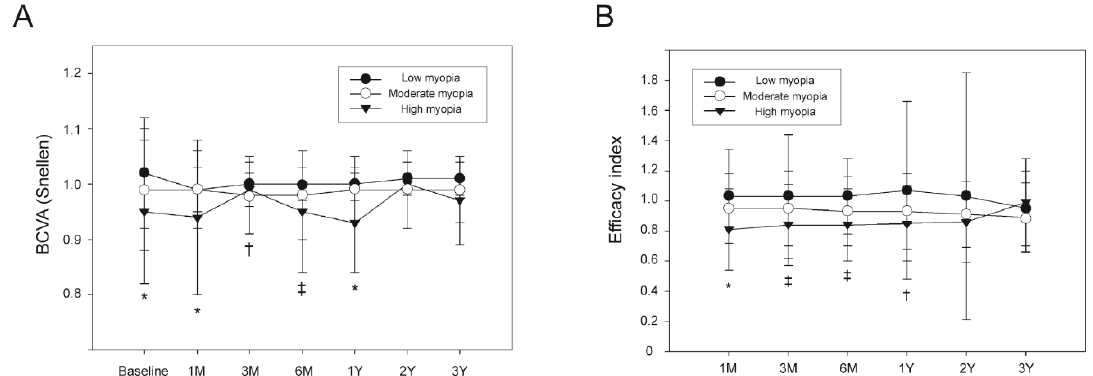
Figure 5. Comparison of best corrected visual acuity and efficacy index according to the degree of myopia. ( A ) BCVA. ( B ) efficacy index. *: significant difference among the three myopia groups ( p < 0.050). †: signi fi cant di ff erence between the low and moderate myopia groups ( p < 0.050). ‡: signi fi cant di ff erence between the low and moderate myopia groups, and between the low and high myopia groups ( p < 0.050). BCVA = best corrected visual acuity.